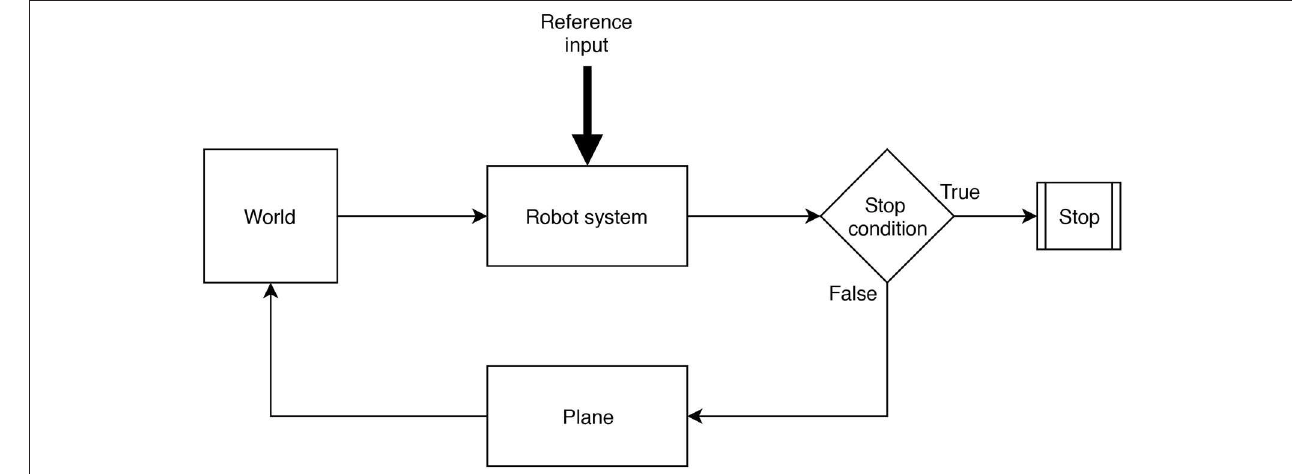
FIGURE 5 | Control architecture.